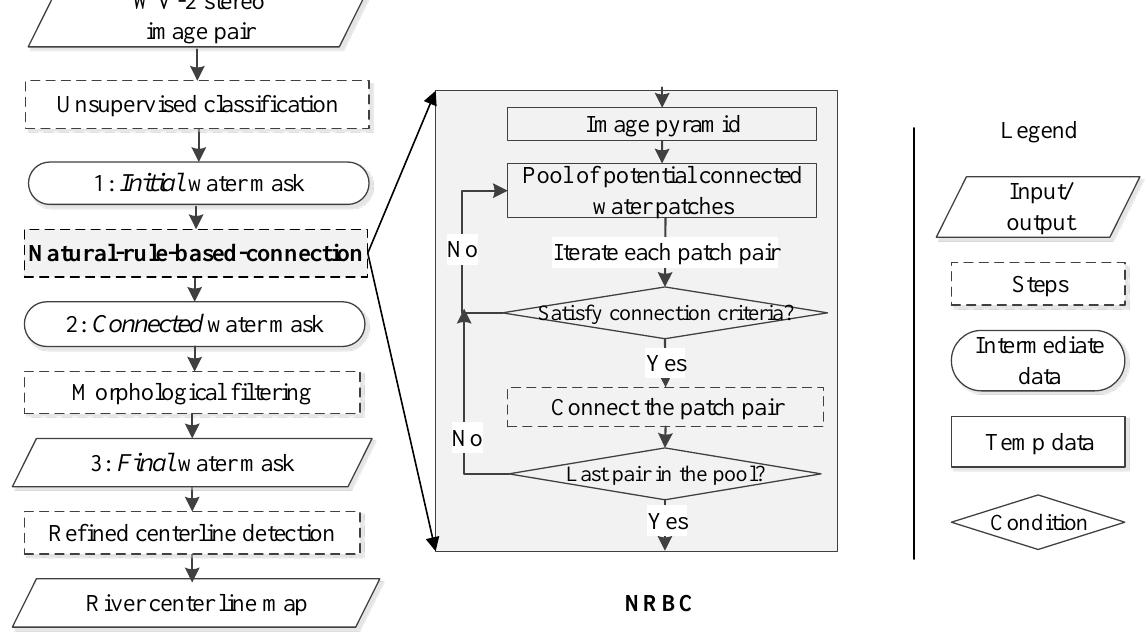
Figure 2. The flowchart of water body detection and